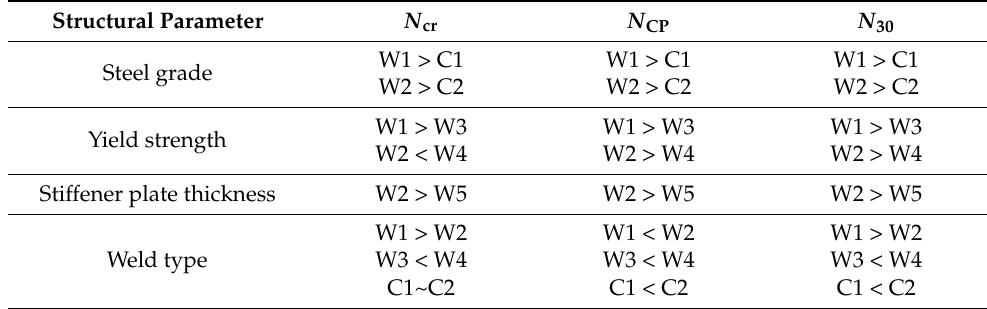
Table 4. Comparison of fatigue